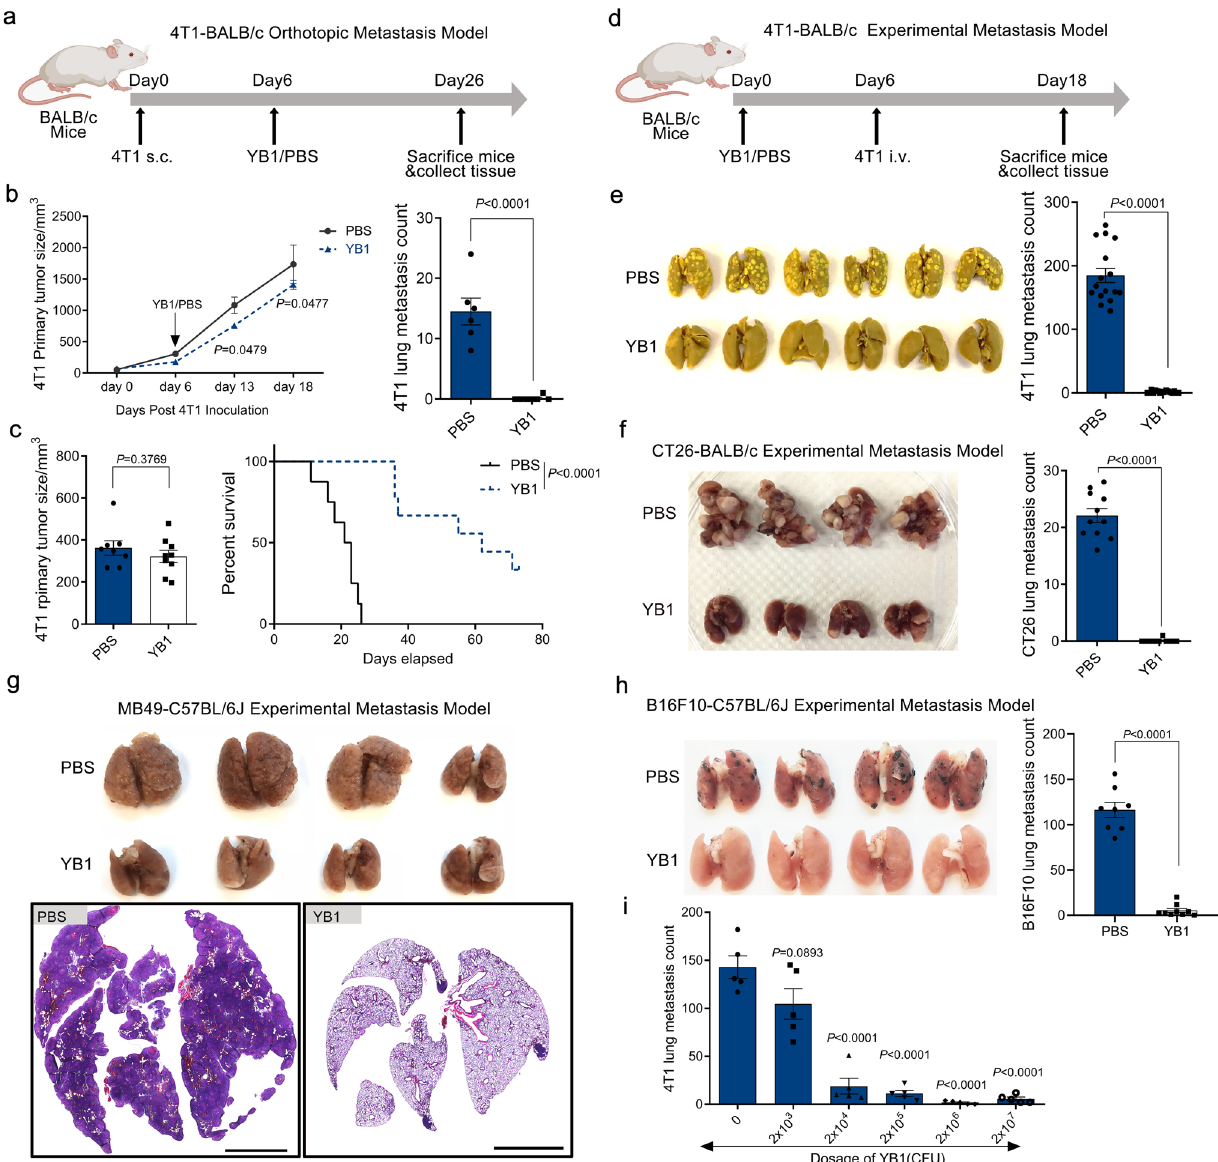
Fig. 1 Salmonella YB1 treatment inhibits cancer metastasis in multiple syngeneic mouse tumor models. a Overall procedures to establish 4T1-BALB/c orthotopic metastasis model. Cancer cell inoculation was followed by treatment with YB1 or PBS. b Quanti fi cation of 4T1 primary tumor size (two-sided multiple t -tests) and relevant lung metastasis (unpaired two-tailed t -test) after YB1 treatment in the 4T1-BALB/c orthotopic metastasis model ( n = 6 PBS, n = 7 YB1). c Mice tumor size measured (unpaired two-tailed t -test) before surgical removal of 4T1 primary tumors and relevant Kaplan – Meier survival curve (log-rank test) of these mice ( n = 8 PBS, n = 9 YB1). d Procedure to establish 4T1-BALB/c experimental metastasis model. 4T1 cells were i.v. injected into BALB/c mice pretreated with YB1 or PBS. e Picture of lungs fi xed in Bouin solution and quanti fi cation (unpaired two-tailed t -test, displayed is a combined result of three independent experiments, n = 16 per group) of 4T1 lung metastases after YB1 treatment in the 4T1-BALB/c experimental metastasis model. f Picture of lungs and quanti fi cation (unpaired two-tailed t -test, n = 11 per group) of lung metastases after YB1 treatment in an experimental metastasis model established by colon cancer (CT26) in BALB/c mice. g Picture of 4% PFA- fi xed lungs and representative H&E staining of lung tissue in an experimental metastasis model established by bladder cancer (MB49) in C57BL/6J mice ( n = 4 mice per group). Scale bar, 3 mm. Condensed tumor nodules were stained with H&E from PBS samples. h Picture of lungs and quanti fi cation (unpaired two-tailed t -tests) of lung metastases after YB1 treatment in the experimental metastasis model established by inoculation of melanoma (B16F10) in C57BL/6J mice ( n = 8 PBS, n = 9 YB1). i Quanti fi cation of 4T1 lung metastases in the 4T1-BALB/c experimental metastasis model after treatment with different doses of YB1 ( n = 5 per group). P -values are comparisons between no YB1 treatment and different dosages of YB1 treatment using unpaired two-tailed t -tests. Graphs and images presented are one representative experiment of two independent experiments ( b , c , g , i ). Graph presented is a combined result of two independent experiments ( f , h ). All data are presented as mean values± SEM. Source data are provided as a Source Data fi le.